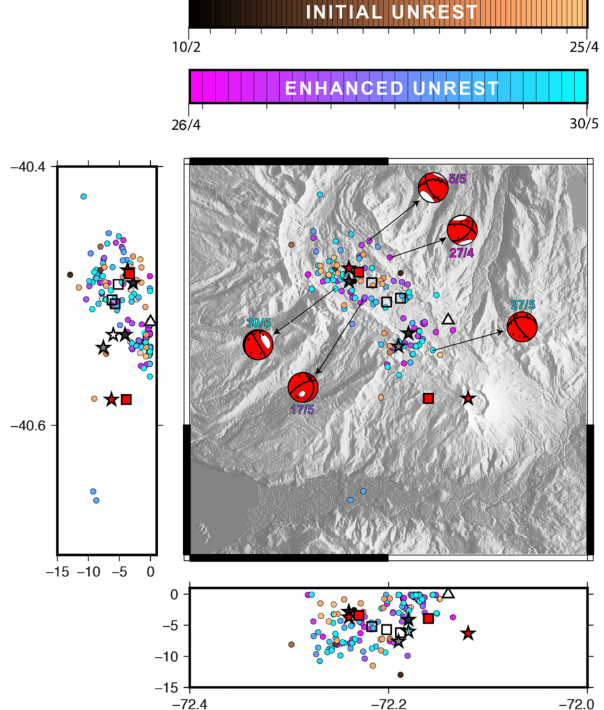
Figure 5. Relocations of seismicity recorded before eruption on- set including the initial and enhanced phases. The locations of hypocenters are indicated with circles, with colors representing time in days (see color codes at the top of the figure with numbers show- ing the day and month during 2011). Red and white circles with numbers are focal mechanisms with the date of occurrence calcu- lated by inversion using ISOLA software. The black squares located inside the inversions represent the polarities, complementing the so- lutions of focal mechanism inversions. The black arrows connect the epicenters with the focal mechanisms solution. The white trian- gle is the eruptive vent. Locations of deformation sources modeled by Jay et al. (2014, stars) and Wendt et al. (2016, squares) are ei- ther transparent (if they are inactive at the time of the initial and enhanced unrest phases) or red (if they were active during the erup- tion onset). The negative numbers in the profiles represent depth in km from the reference level of the 1D seismic velocity model (at